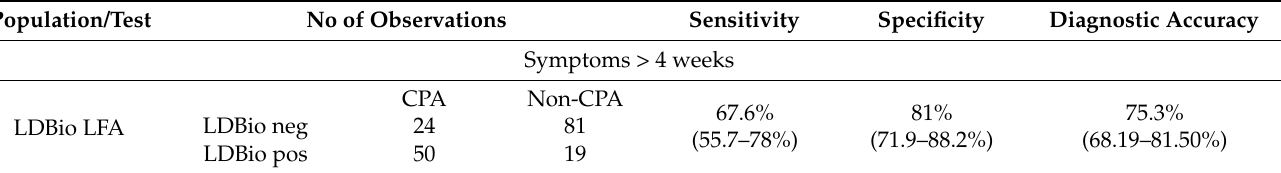
Table 4. The kappa for agreement between LDBio LFA and Aspergillus fumigatus was 0.53. Table 4. Sensitivity & specificity of LDBio LFA kit & ImmunoCAP Asp IgG (cut off >27